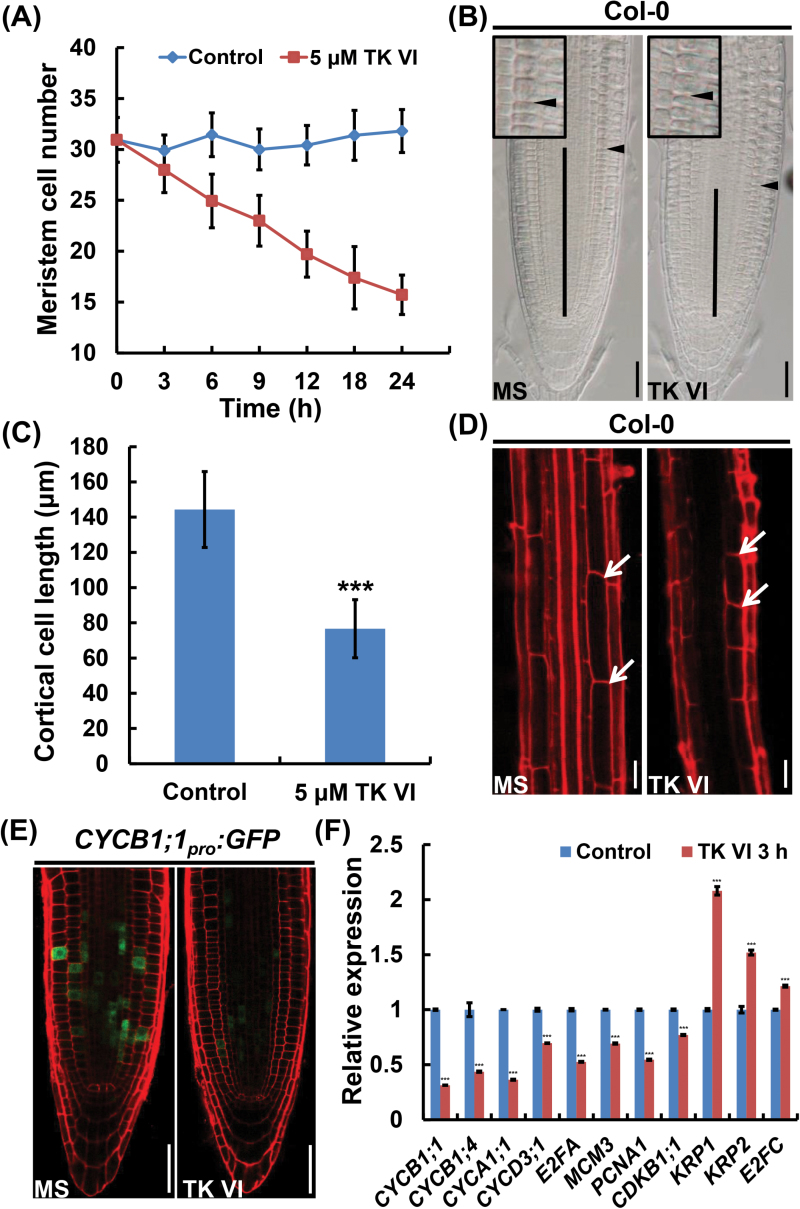
TK VI-induced inhibition of cell proliferation and cell elongation in the Col-0 root tip. (A) Time course of TK VI-induced reductions in root meristem size in Col-0 seedlings at 5 DAG. Data shown are averages with the SD (n=20). (B) Root meristems of 5 DAG Col-0 seedlings transplanted to medium without (MS) or with 5 μM TK VI for 12h. The meristem is marked with a vertical black line. The boundary between the meristem zone and the elongation zone is marked with a black arrowhead. The black box is an enlarged image of the boundary between the meristem zone and the elongation zone. (C) Cortical cell length in the differentiation zone of 5 DAG Col-0 seedlings grown on medium without (Control) or with 5 μM TK VI. Data shown are averages with the SD (n=20). The asterisks denote Student’s t-test significance compared with untreated plants: ***P<0.001.(D) Differentiation zones of seedlings mentioned in (C). The white arrowheads indicate the length of a single cortical cell. (E) TK VI-induced reduction in CYCB1;1
pro
:GFP expression in Col-0. Six-day-old seedlings were transferred to medium without (MS) or with 5 μM TK VI for 3h before GFP fluorescence was monitored. (F) The effect of TK VI on the expression of cell cycle-related genes in the Col-0 root tip. Six-day-old Col-0 seedlings were transplanted to medium without (Control) or with 5 μM TK VI for 3h, and the 2mm root tips were harvested for RNA extraction and qRT–PCR analysis. The transcript levels of the indicated genes in Col-0 without TK VI treatment were arbitrarily set to 1. The error bars represent the SD of triplicate reactions. The asterisks denote Student’s t-test significance compared with untreated plants: ***P<0.001. Scale bars=50 μm (B, D, E).